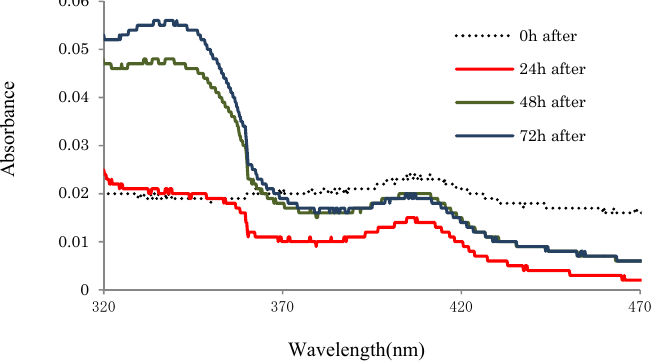
6 of 12 Figure 2. Time course of the asymmetric oxidation activity ( ‐□‐ : % ee ) using expressed HasApf